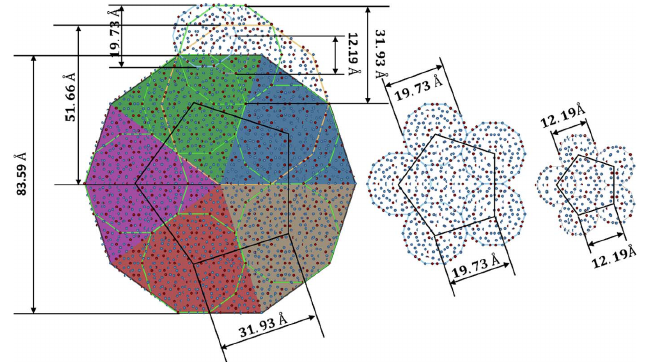
Figure 9 Scaling property of the DQC for decagonite. Decagonal clusters at five different length scales are presented. The characteristic motif of five decagons with a star-like cluster in the center is also shown. This motif is often used to define the atomic decoration of clusters for the cluster- embedding